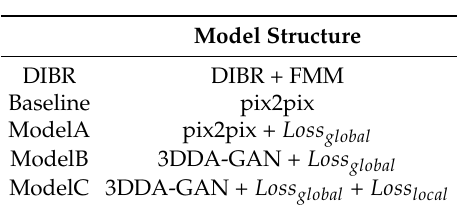
Table 2. Model list.